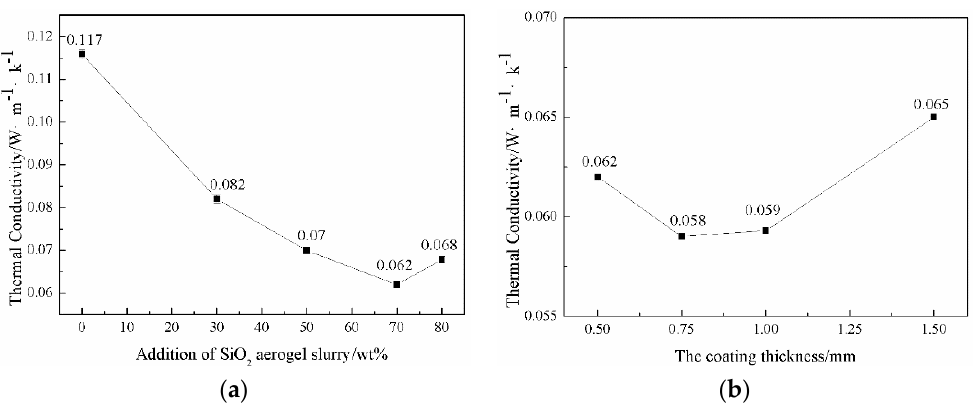
Figure 6. Thermal conductivity of the thermal insulation layer: ( a ) different SiO 2 aerogel slurry addition amounts; ( b ) different coating thicknesses.